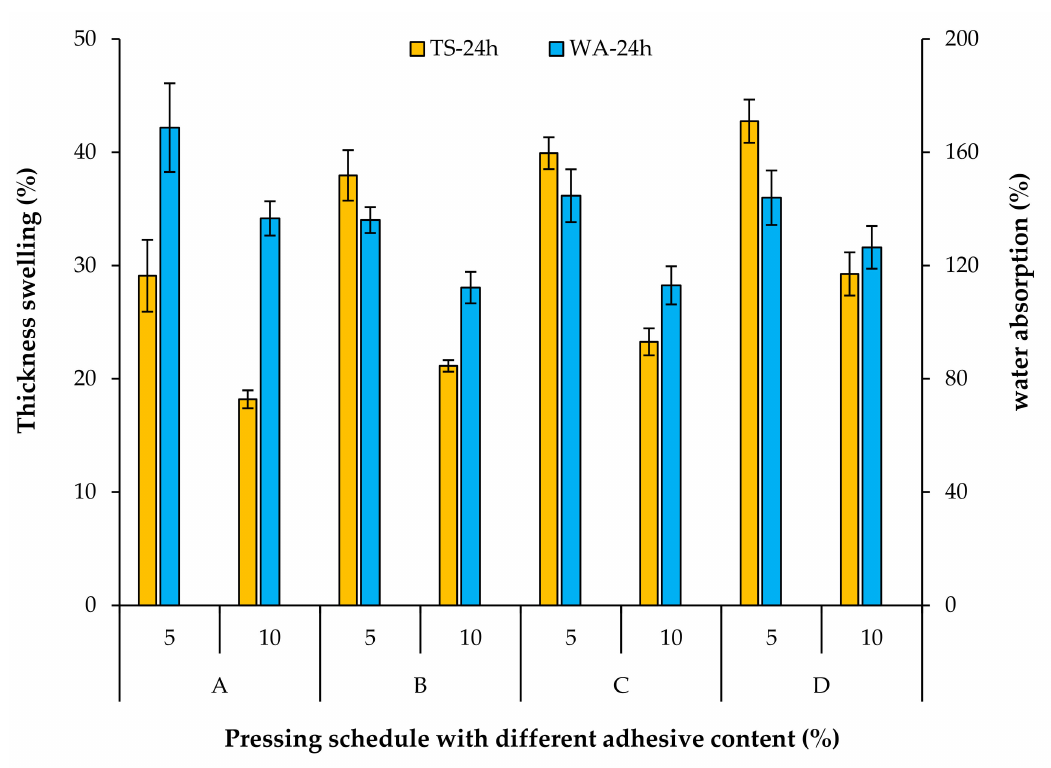
Figure 7. Thickness swelling and water absorption of fiberboards produced with different pressing schedules and adhesive